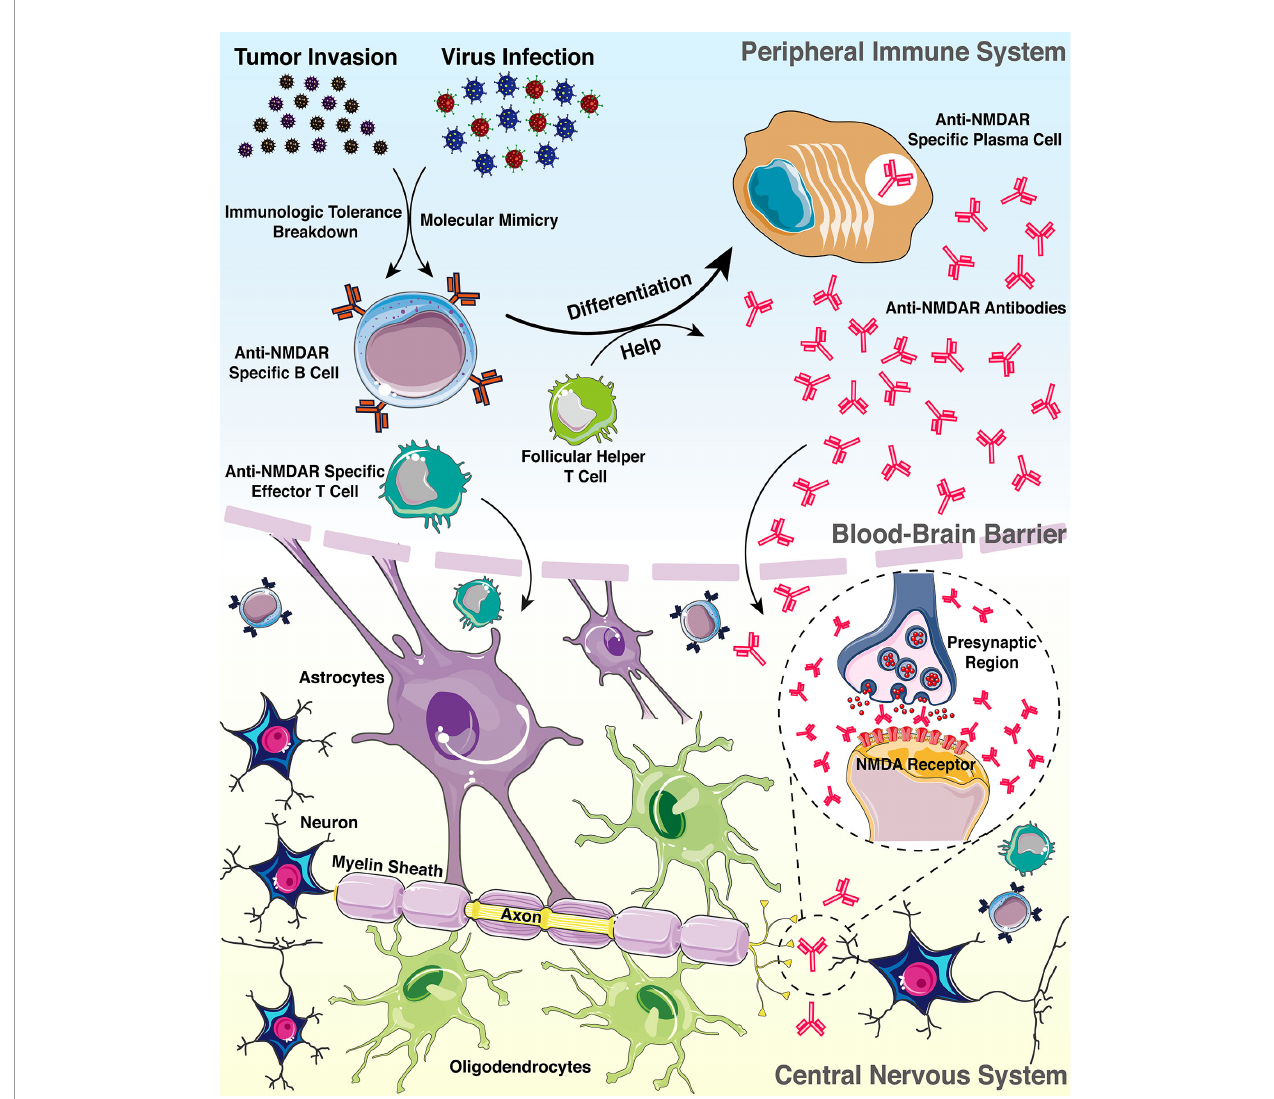
FIGURE 2 | Pattern diagram of the possible mechanisms connecting anti-NMDAR antibody with